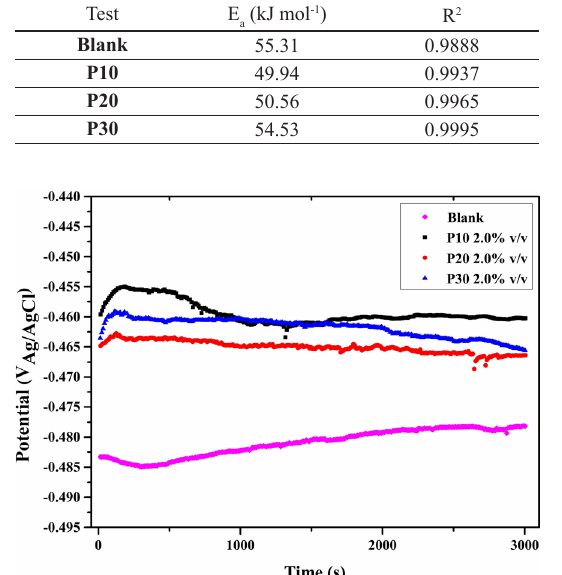
Figure 9. Linear polarization resistance curves for immersed API P110 carbon steel coupons in the absence and presence of P10, P20 and P30 (2.0% v/v), at 303